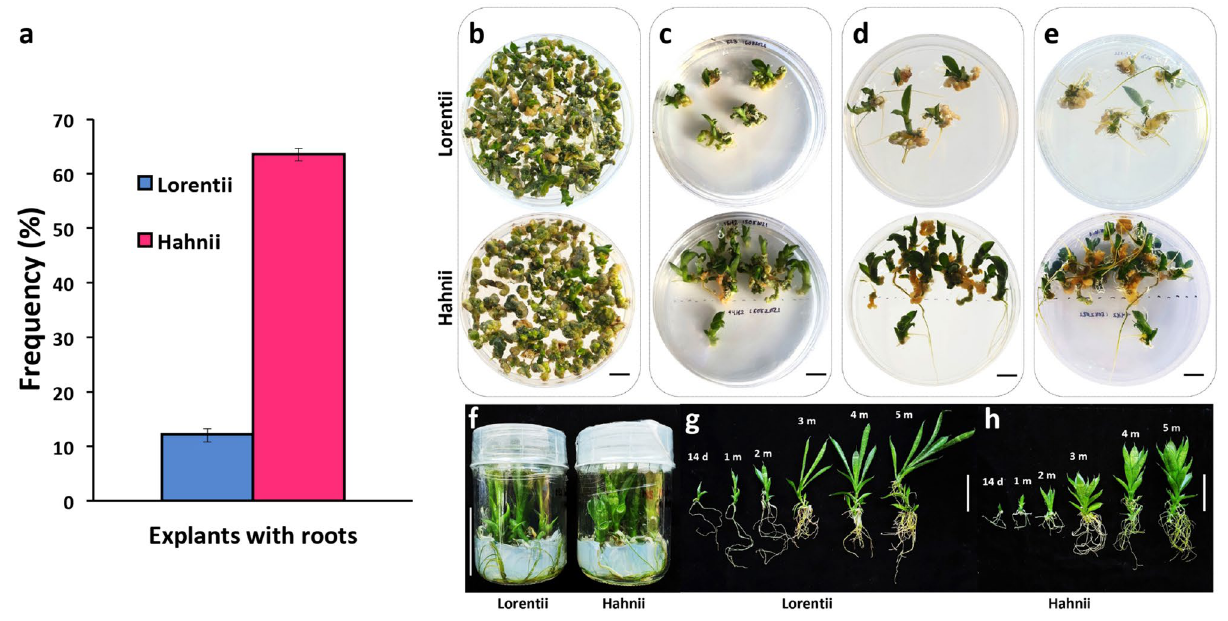
Figure 7. Rooting phase during micropropagation of cvs Lorentii and Hahnii of Sansevieria trifasciata. ( a ) Root formation in leaf explants of Sansevieria trifasciata incubated in basal 1X MS medium. Root development after ( b ) 12 weeks, ( c ) 16 weeks, and ( d ) (top view) and ( e ) (bottom view) 18 weeks on auxin-free 1X MS medium + 4.0 mg·Lˉ1 BAP. ( f ) Seedlings in hormone-free 1X MS medium. ( g , h ) Root development on plantlets growing on hormone-free 1X MS medium. Values are mean ± SD. Black bar = 1 cm, white bar = 5